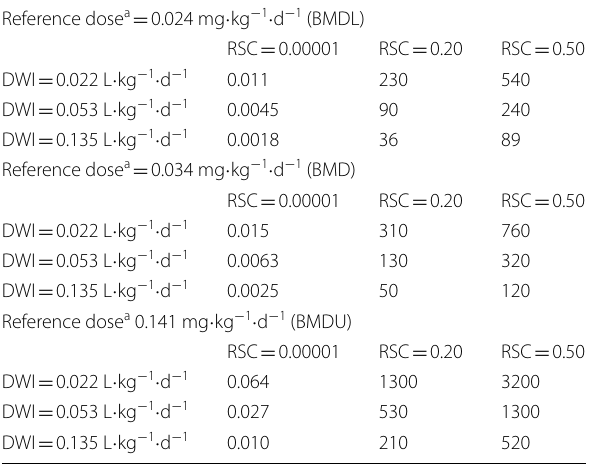
Table 4 Sensitivity analysis of screening level (μg the most sensitive POD identified as a reduction in